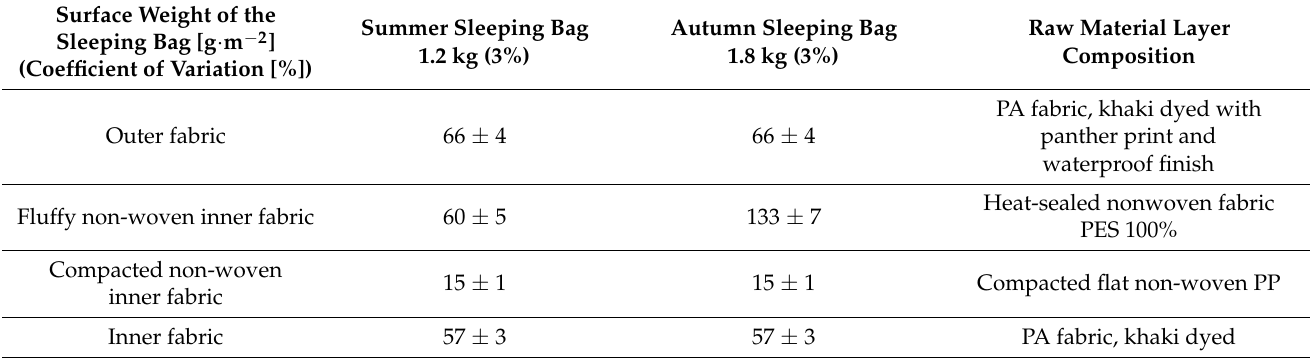
Table 1. Basic data on the weight of sleeping